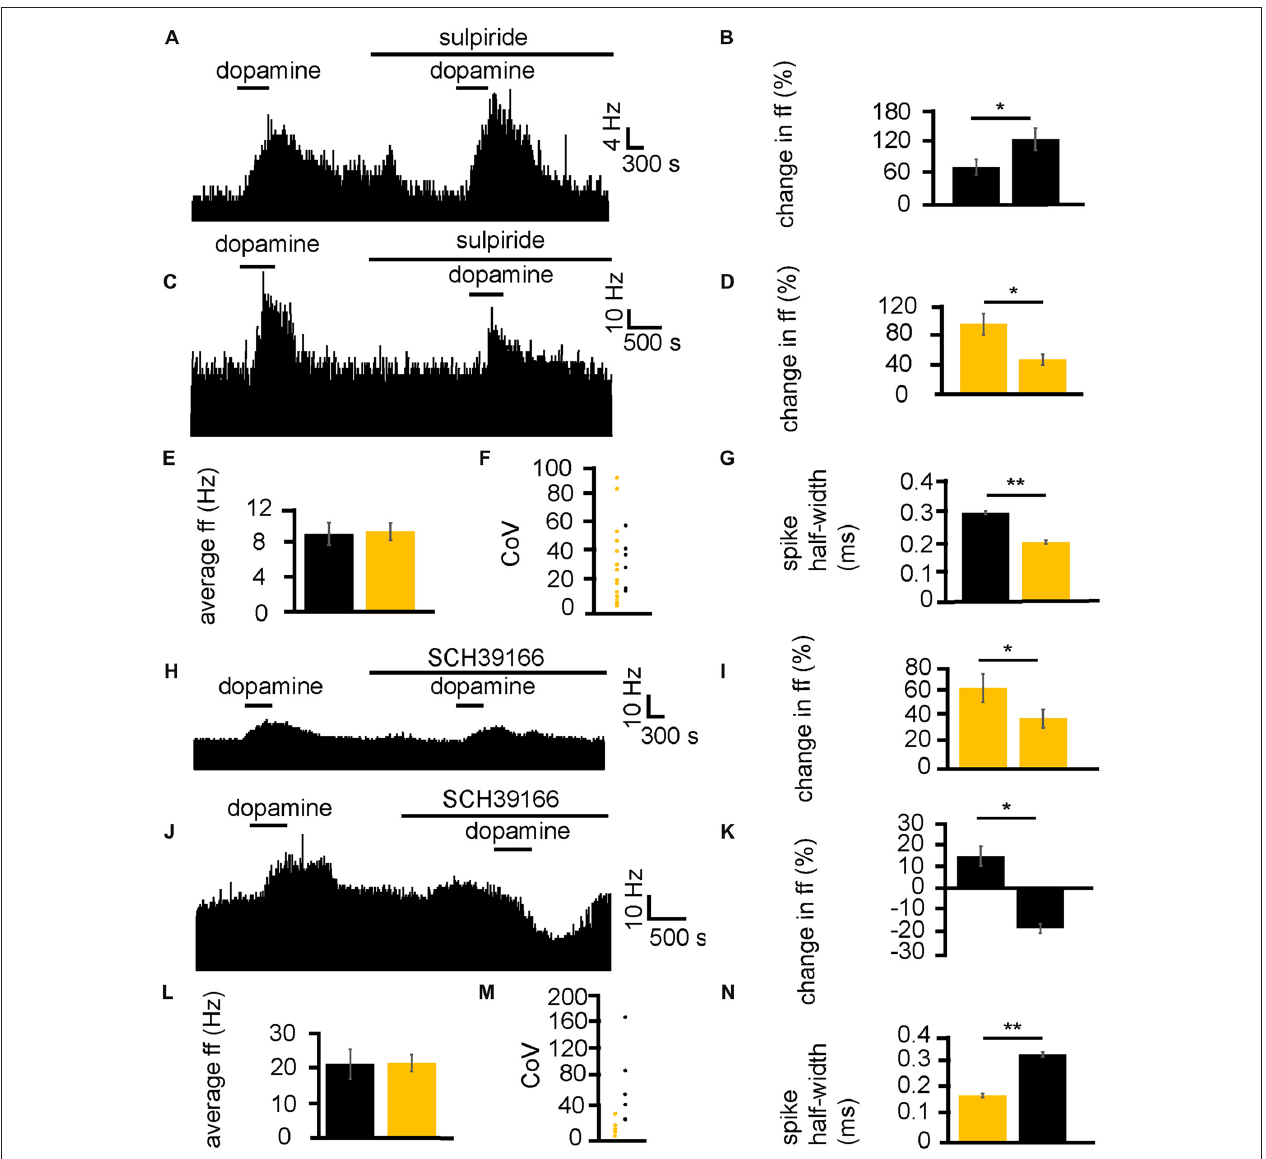
FIGURE 5 | D1-like and D2-like receptor antagonists modulate the effect of dopamine in the VP. (A) For some neurons, when dopamine was applied in the presence of sulpiride, it produced a larger increase in firing than when it was applied in the absence of sulpiride. (B) Firing frequency changes to dopamine application in control and in the presence of sulpiride, for neurons similar to that illustrated in panel (A) . (C) For some neurons, when dopamine was applied in the presence of sulpiride, it produced a smaller increase in firing than when it was applied in the absence of sulpiride. (D) Firing frequency changes to dopamine application in control and in the presence of sulpiride, for neurons similar to that illustrated in panel (C) . (E) Firing frequency changes to dopamine application for neurons that showed a larger increase in firing to dopamine application (black) in the presence of sulpiride and neurons that showed a smaller increase in firing to dopamine application in the presence of sulpiride (yellow). (F) CoV for neurons that showed a larger increase in firing to dopamine in the presence of sulpiride (black) and those that showed a smaller increase in firing to dopamine in the presence of sulpiride (yellow). (G) Significant differences in spike half-width (ms) for neurons that showed a larger increase in firing to dopamine in sulpiride (black) compared to those that showed a smaller increase in firing to dopamine in sulpiride (yellow). (H) For some neurons, when dopamine was applied in the presence of SCH39166, it produced a smaller increase in firing than when it was applied in the absence of SCH39166. (I) Firing frequency changes during dopamine application and dopamine in the presence of SCH39166, for neurons similar to that illustrated in panel (H) . (J) Excitatory responses to dopamine application followed (after complete washout of dopamine) by inhibitory responses to dopamine application in the presence of SCH39166. (K) Firing frequency changes during application of dopamine and dopamine in the presence of SCH39166, for neurons similar to those illustrated in panel (J) . (L) Firing frequency changes to dopamine application for those neurons that showed a smaller increase in firing to the application of dopamine in the presence of SCH39166 (yellow), and those that showed a decrease in firing frequency to dopamine in the presence SCH39166 (black). (M) CoV for neurons that showed a smaller increase in firing to dopamine in the presence of SCH39166 (yellow), and those that showed a decrease in firing frequency to dopamine in the presence of SCH39166 (black). (N) Significant differences in spike half-width (ms) for those neurons that showed a smaller increase in firing to dopamine in the presence of SCH39166 (yellow), compared to those that showed a decrease in firing frequency to dopamine in the presence of SCH39166 (black).